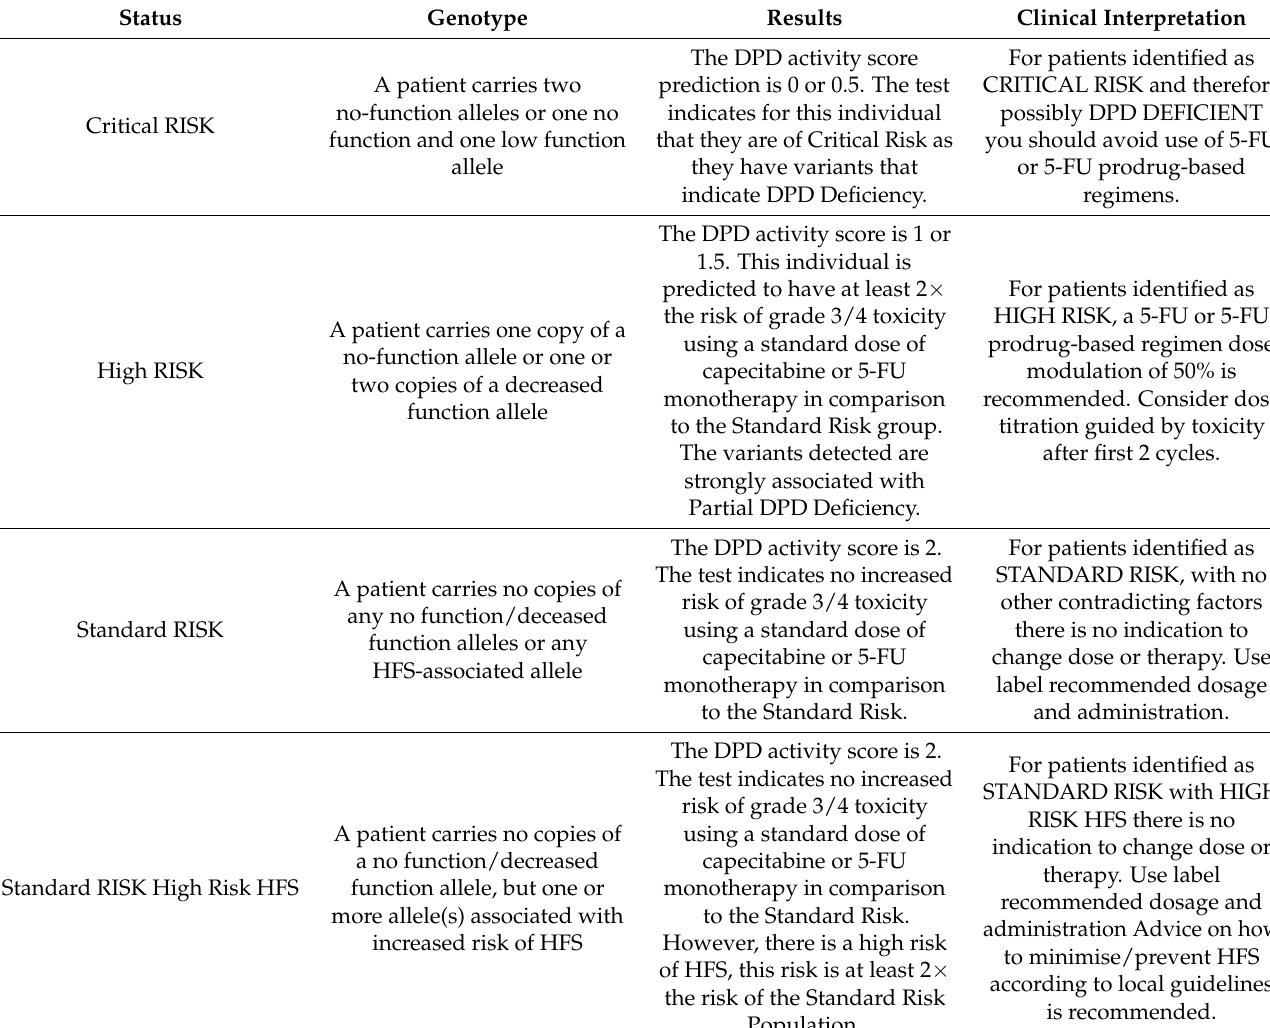
Table 5. Proposed risk classifications for a panel made up of model 2 and model 11